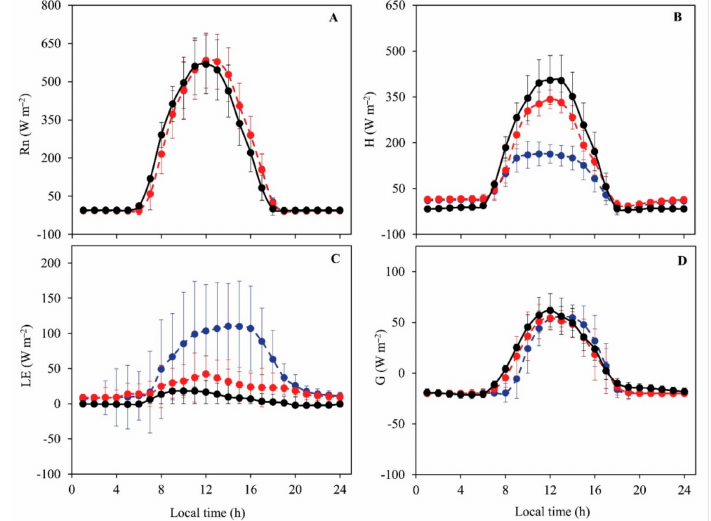
Figure 4. Simulations without calibration (dashed blue lines), simulations with calibration (dashed red lines, simulation U) and eddy covariance observations (solid black lines) of mean daily cycle of energy fluxes during the dry season of 2014. Net radiation (Rn; ( A )), sensible heat flux (H; ( B )), latent heat flux (LE; ( C )) and soil heat flux (G, ( D )). Vertical bars indicate the standard deviation of fluxes. For details on the calibrated parameters of simulation U, see Table